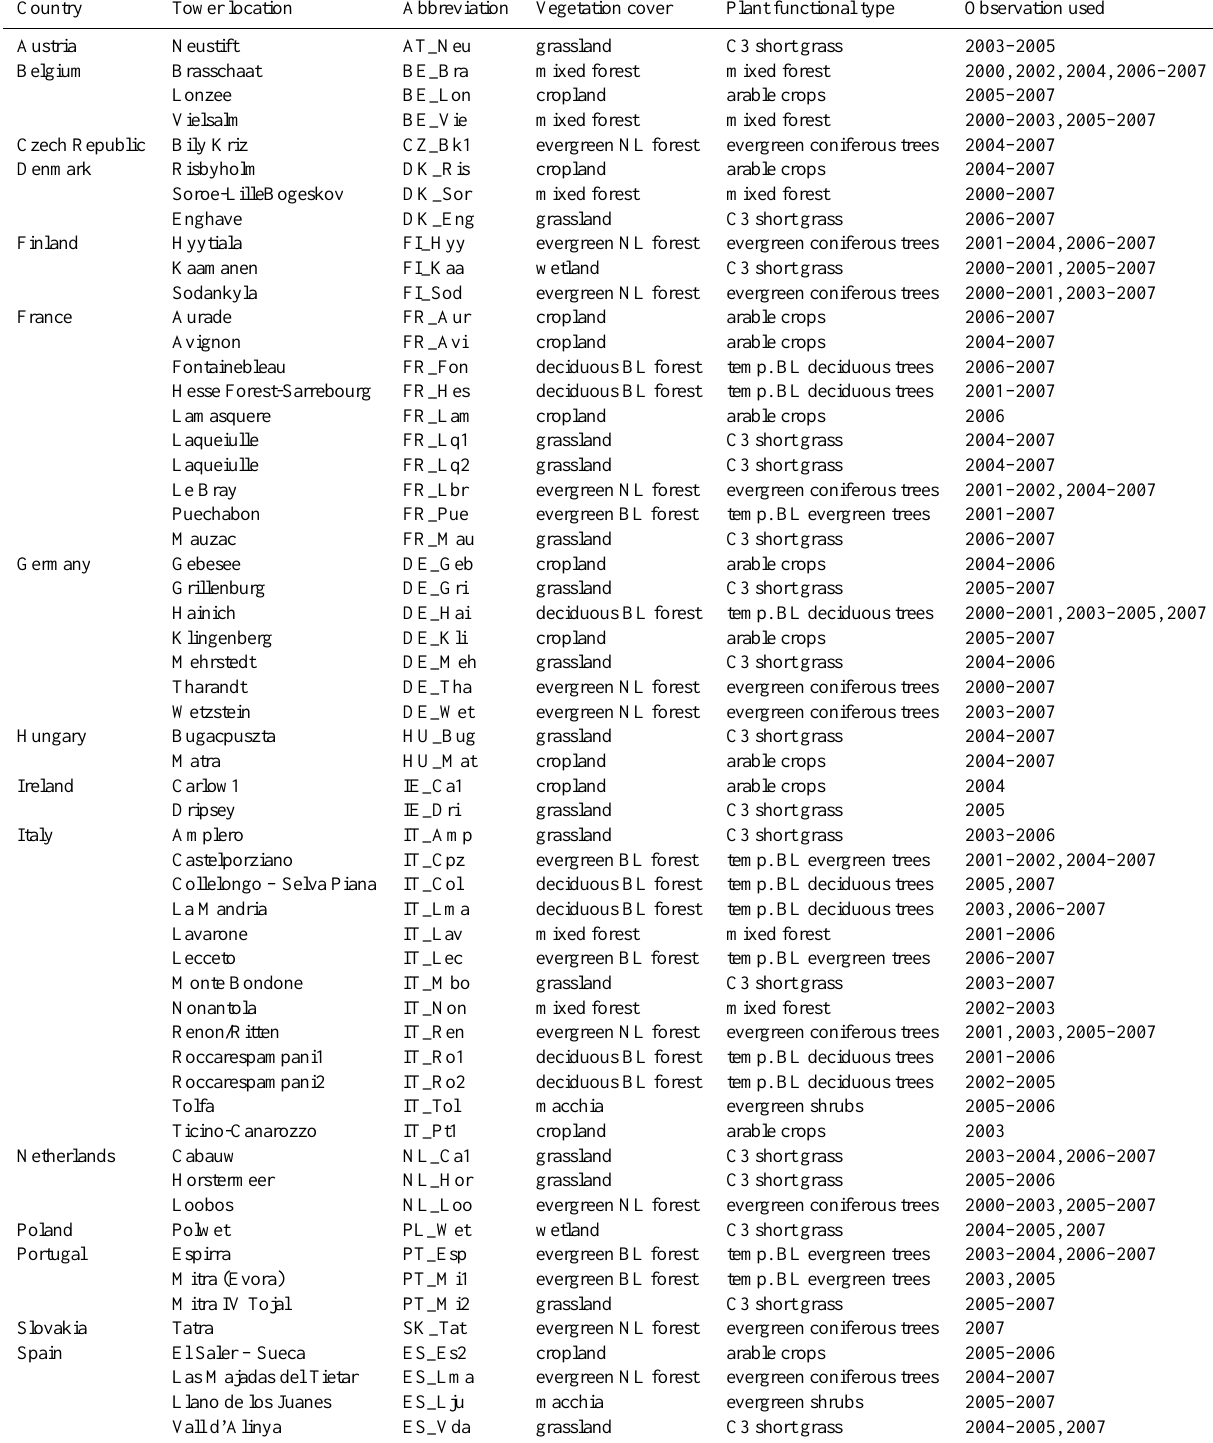
Table 3. 74 FLUXNET tower sites and corresponding vegetation types with associated BETHY/DLR translations and measuring times in between 2000 and